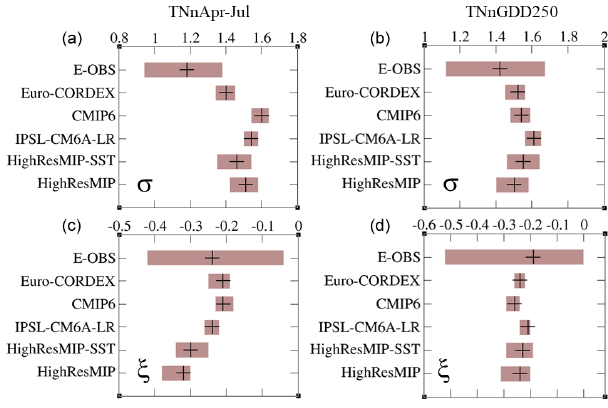
Figure 3. Model evaluation, using two main indices, TNnApr– Jul (a, c) and TNnGDD250 (b, d) . The estimates of the scale pa- rameters are displayed in the first row and the estimates for the shape parameters in the second row. Results for TNnGDD250-350 are qualitatively similar to those for